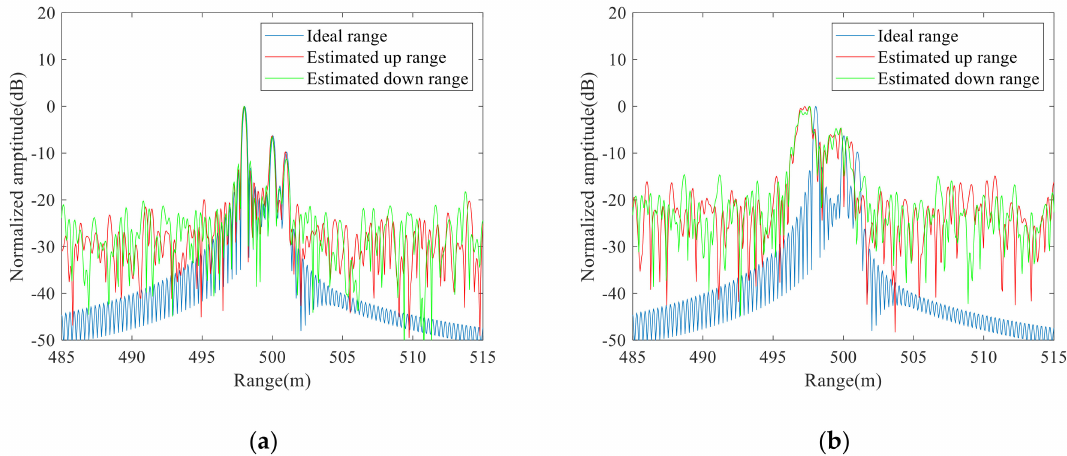
Figure 13. ( a ) One-dimensional range distributions after compensating for the primary vibration errors by using the proposed method; ( b ) One-dimensional range distributions by using the Doppler frequency shift